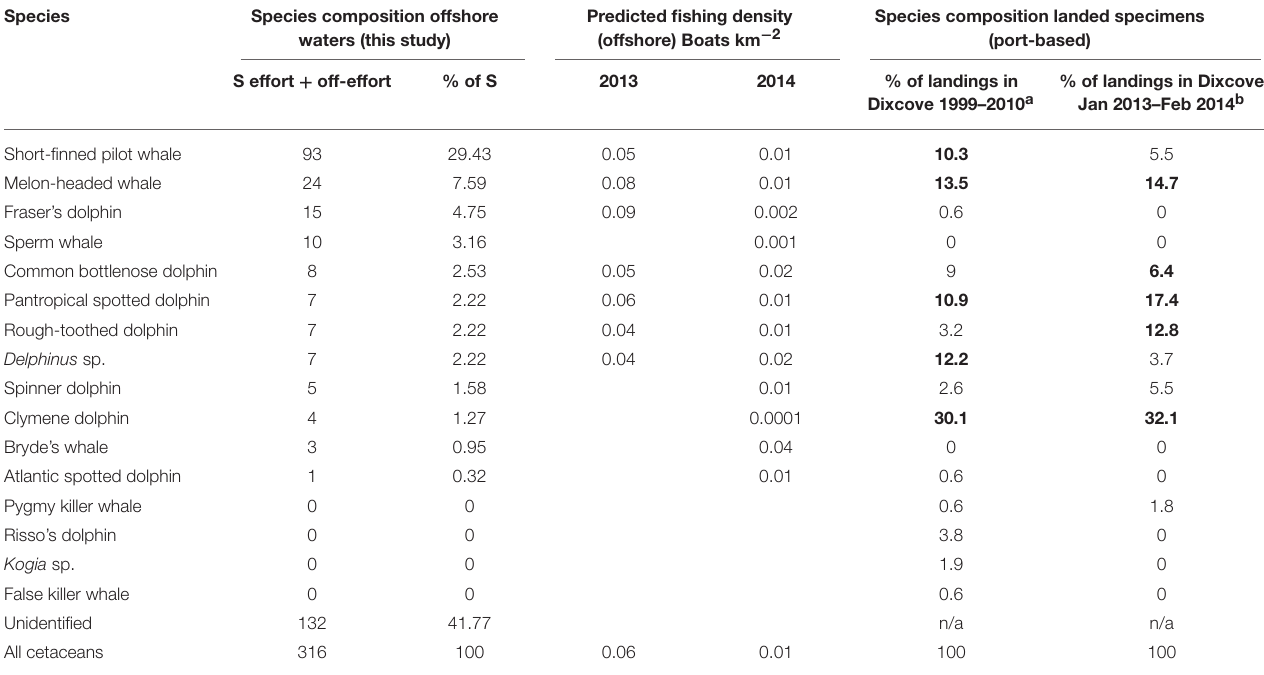
TABLE 3 | Species composition and summary of all cetacean sightings (S; during effort and off-effort search status) pooled from both survey years together with the percentage of all sightings (listed in order of frequency). Species Species composition offshore waters (this